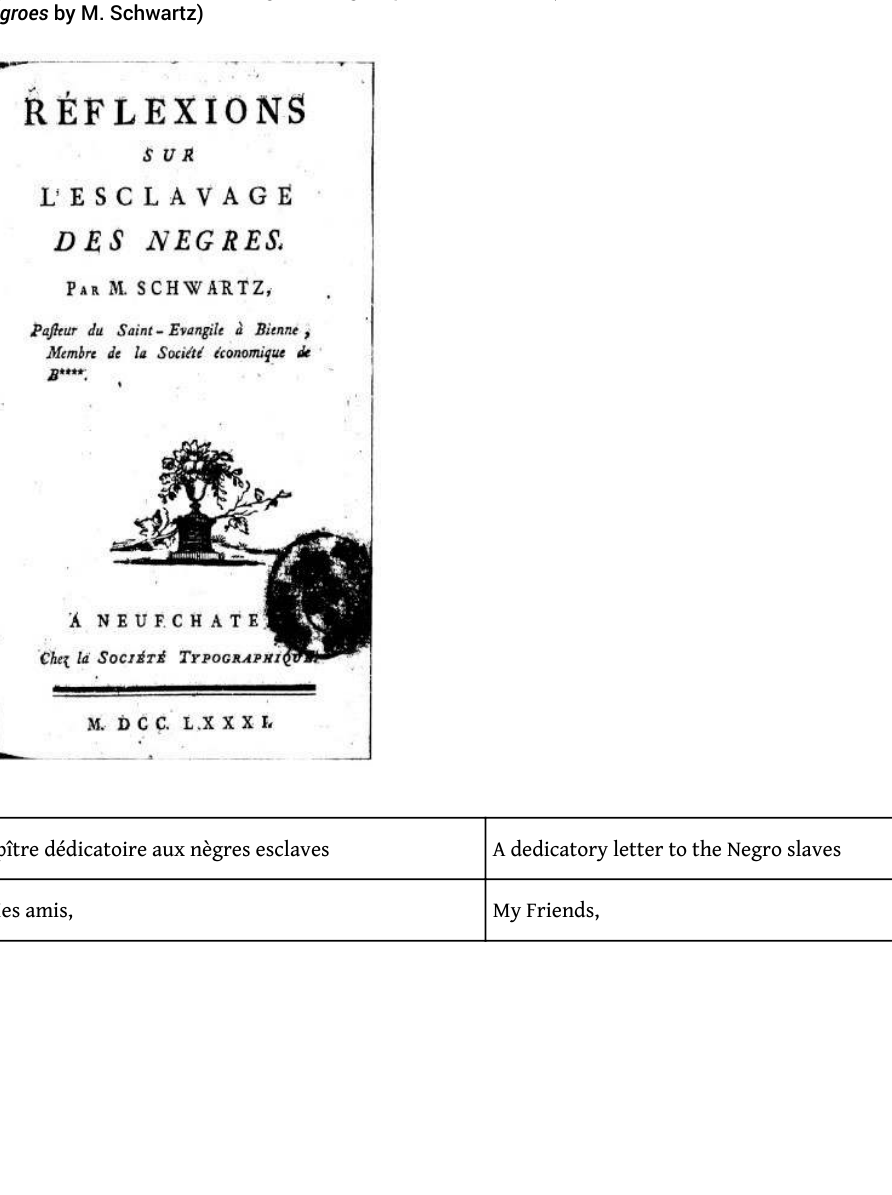
Figure 4. Réflexions sur l'esclavage des nègres par M. Schwartz ( Reflections on the Enslavement Negroes by M. Schwartz)